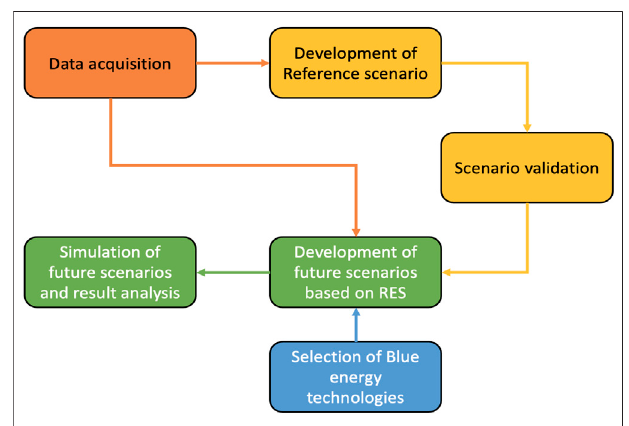
FIGURE 1 | Illustration of the applied